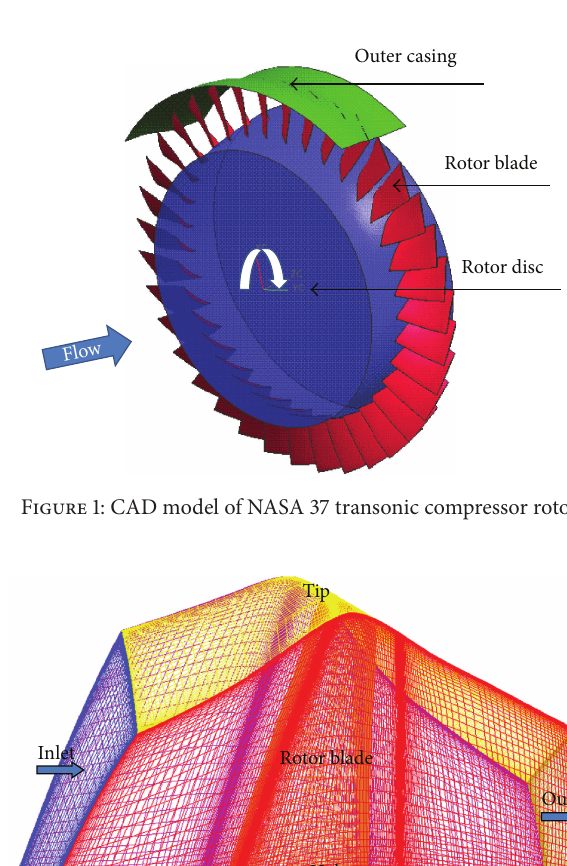
Figure 4: 3D CAD model of aspirated rotor